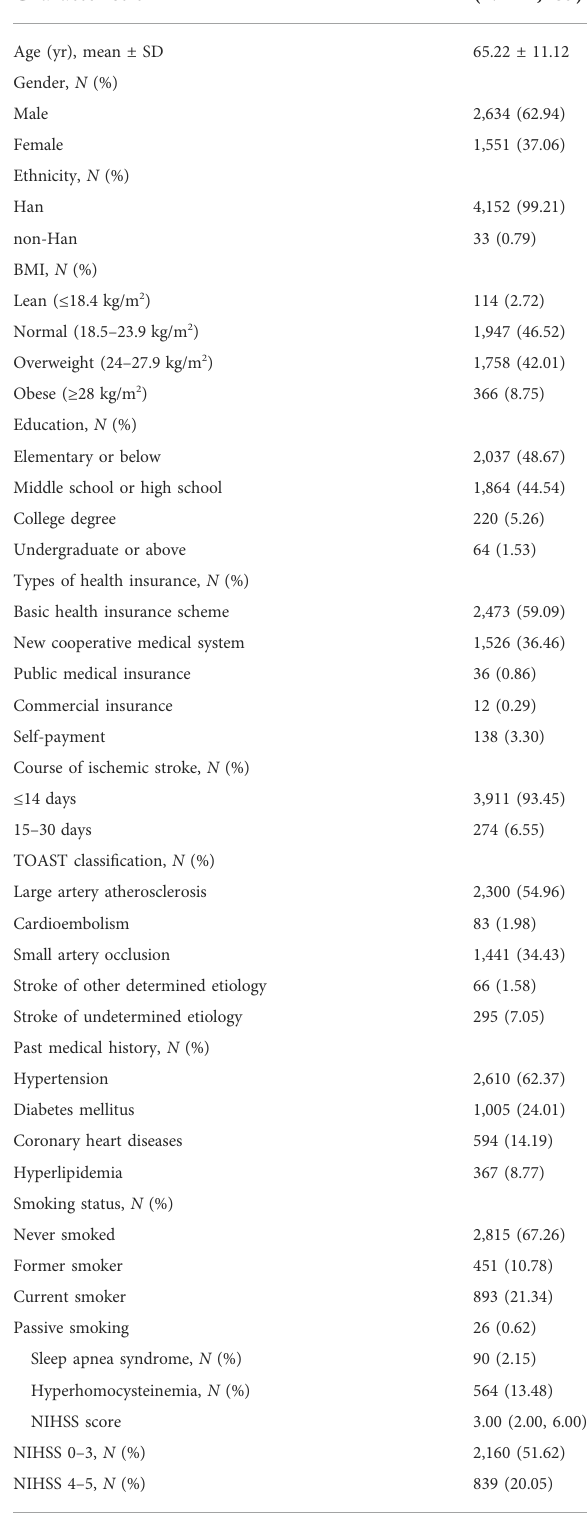
TABLE 2 Baseline characteristics of the registered patients in the VENUS